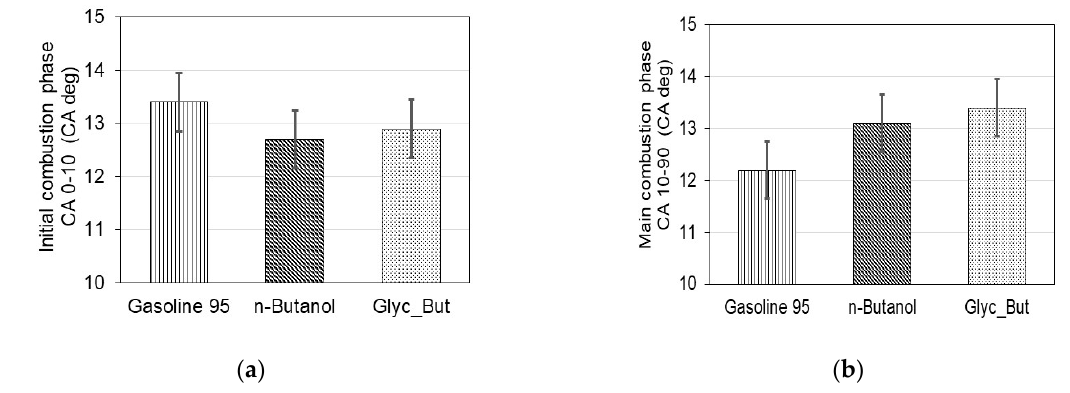
Figure 4. Combustion duration phases: ( a ) CA0-10; ( b ) CA10-90 for the tested fuels at fixed spark timing of − 10 CA deg aTDC.